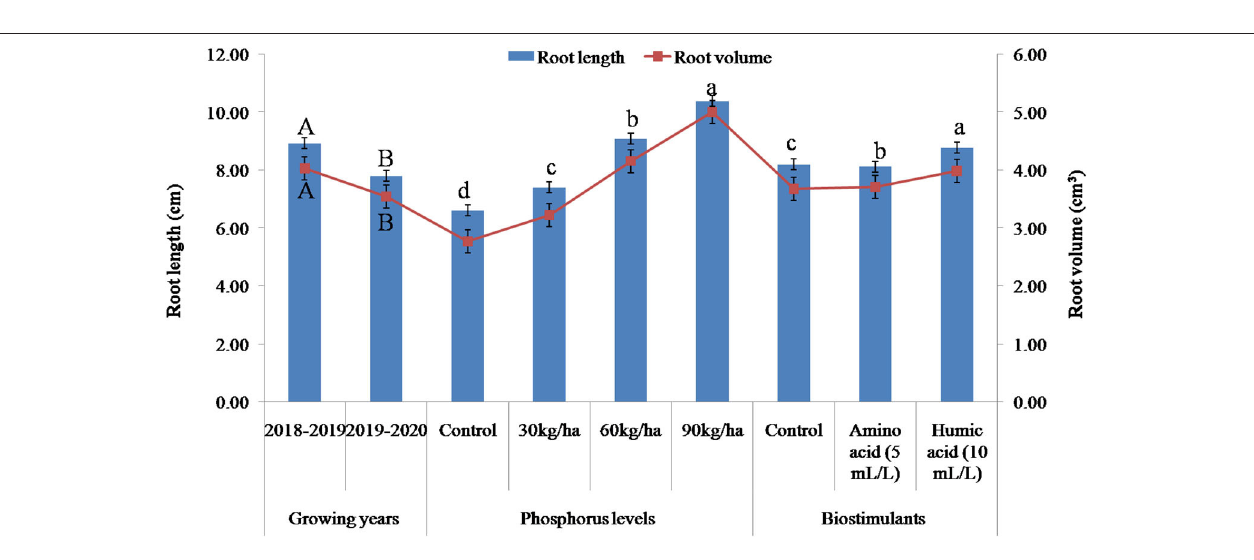
FIGURE 3 | Growing years and phosphorus and biostimulant application affected root length (in cm) and root volume (in cm 3 ) at harvest in M. chamomilla